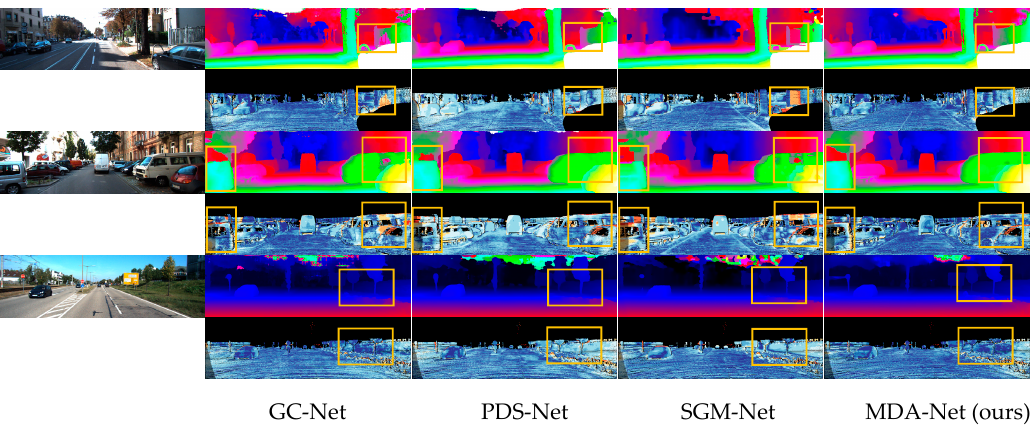
Figure 7. Visualizations of the depth results of KITTI stereo 2015 test set. The first column shows the left images.